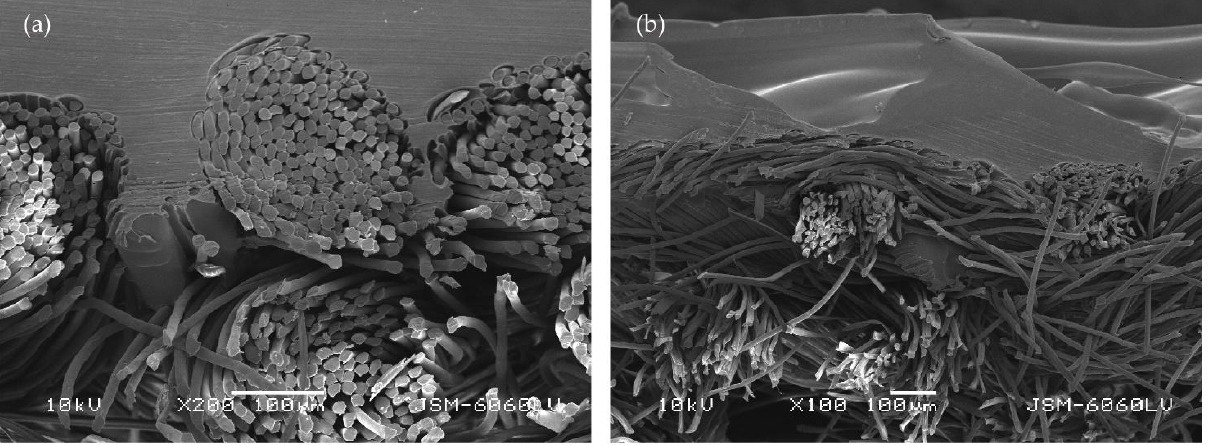
Figure 10. Cross-section of the 3D printed fabric DT13B 40 at z = 0.25 mm: ( a ) cut in the warp direction (mag. 200×); ( b ) cut in the weft direction (mag. 100×).